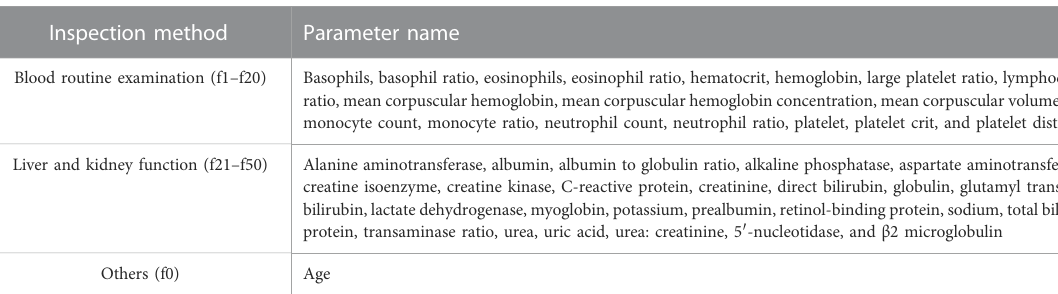
TABLE 2 Clinical